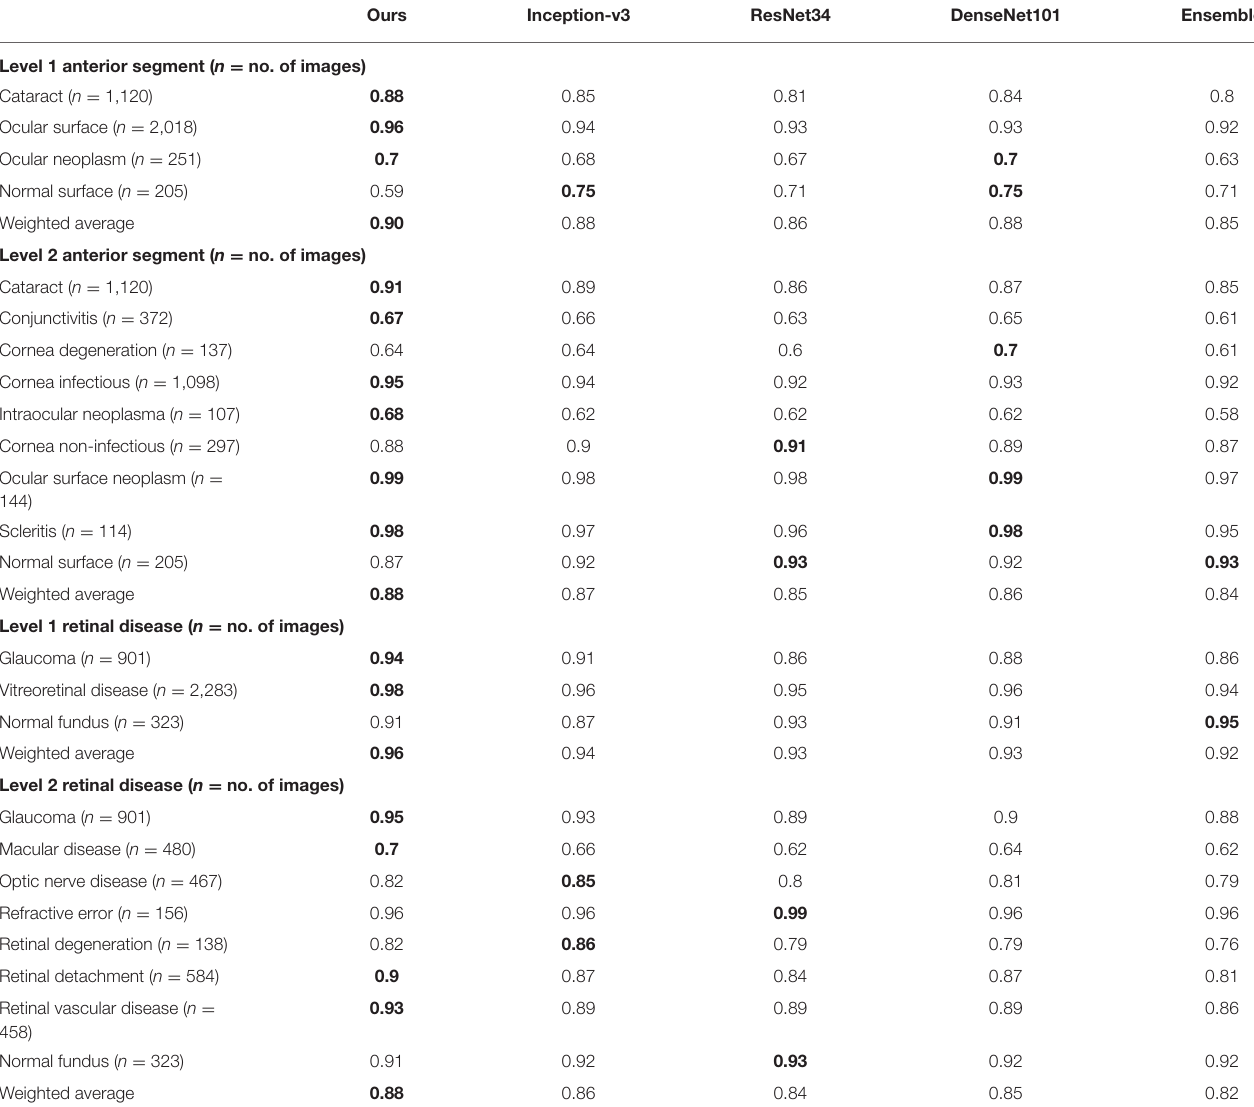
TABLE 5 | Precision comparison between the proposed hierarchical deep learning framework and existing deep learning frameworks. Ours Inception-v3 ResNet34 DenseNet101